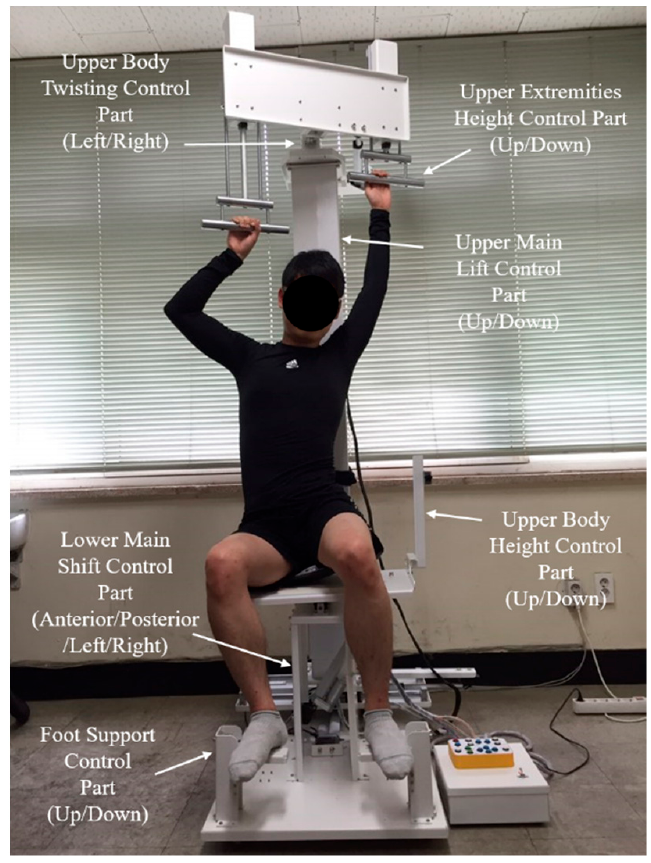
Figure 3. Exercise rehabilitation device.